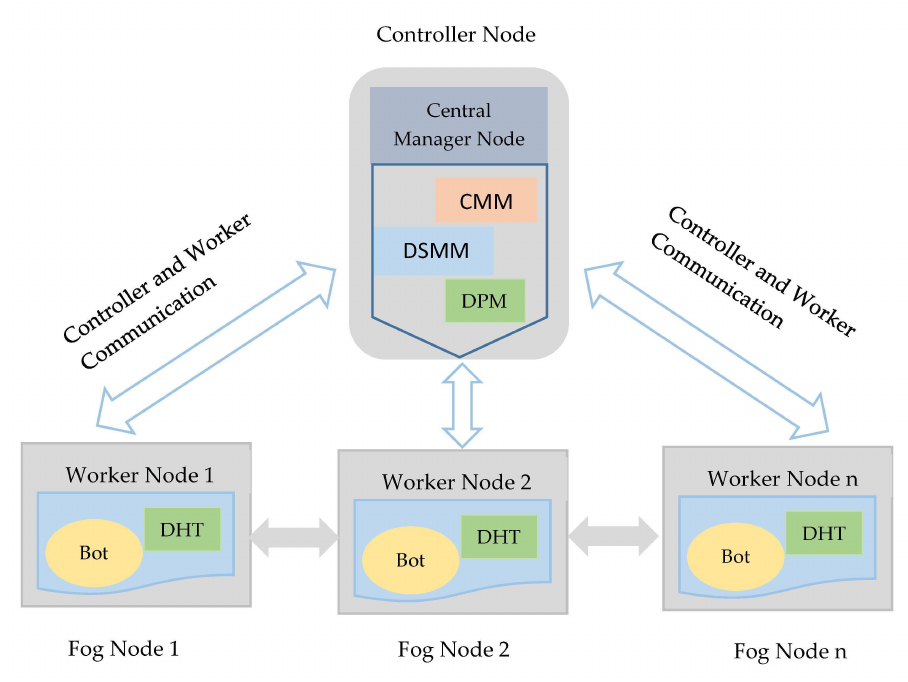
Figure 9. Placement of CMM and DSMM in a controller